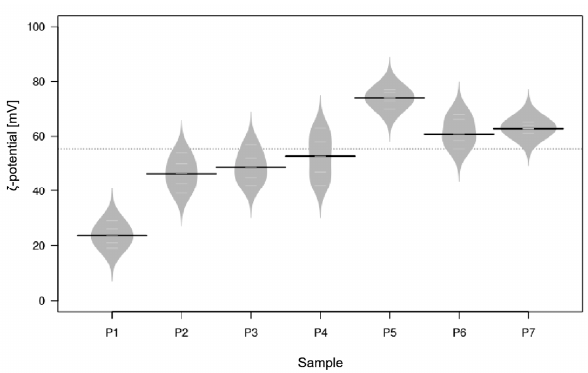
Figure 2. Beanplot graph obtained for the samples. Coatings 2023 , 13 , x FOR PEER REVIEW